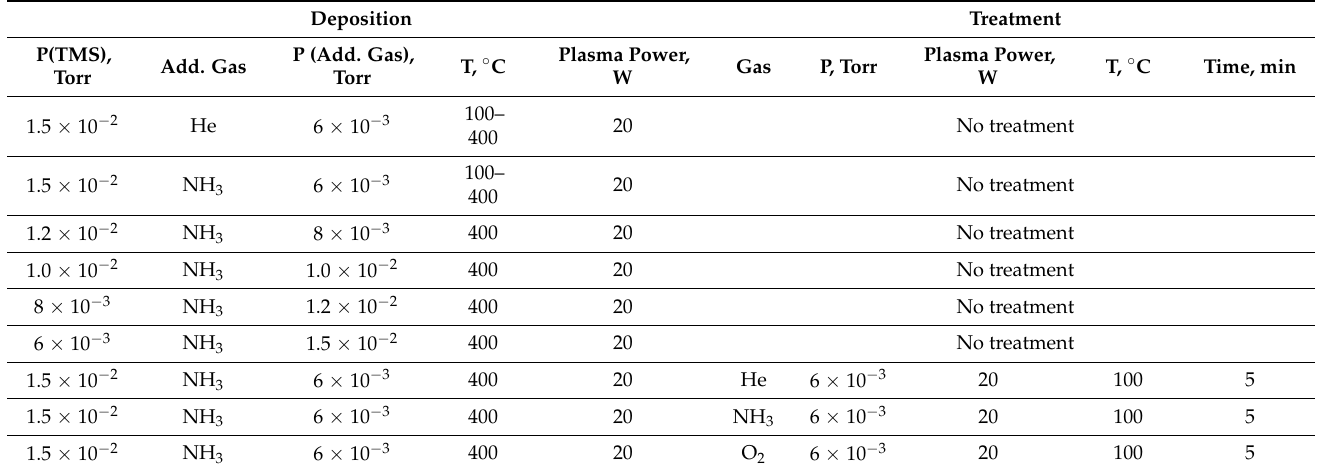
Table 2. Experimental